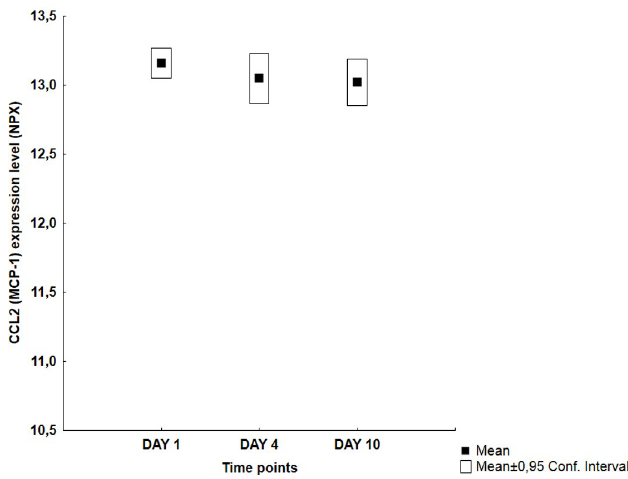
Fig 4. Group D example; CCL2 (MCP-1): Temporal pattern of protein expression level (mean NPX ± 0.95 CI) for C-C motif chemokine ligand 2 (CCL2) a.k.a. monocyte chemotactic protein 1 (MCP-1) showing essentially stable values throughout the whole observation period (13,15 vs 13,04 vs 13,02; p = 0,575).